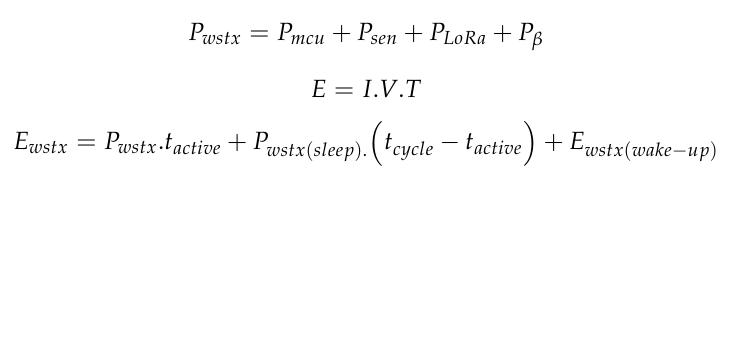
Figure 22. The power consumption percentage of the WSTx elements.